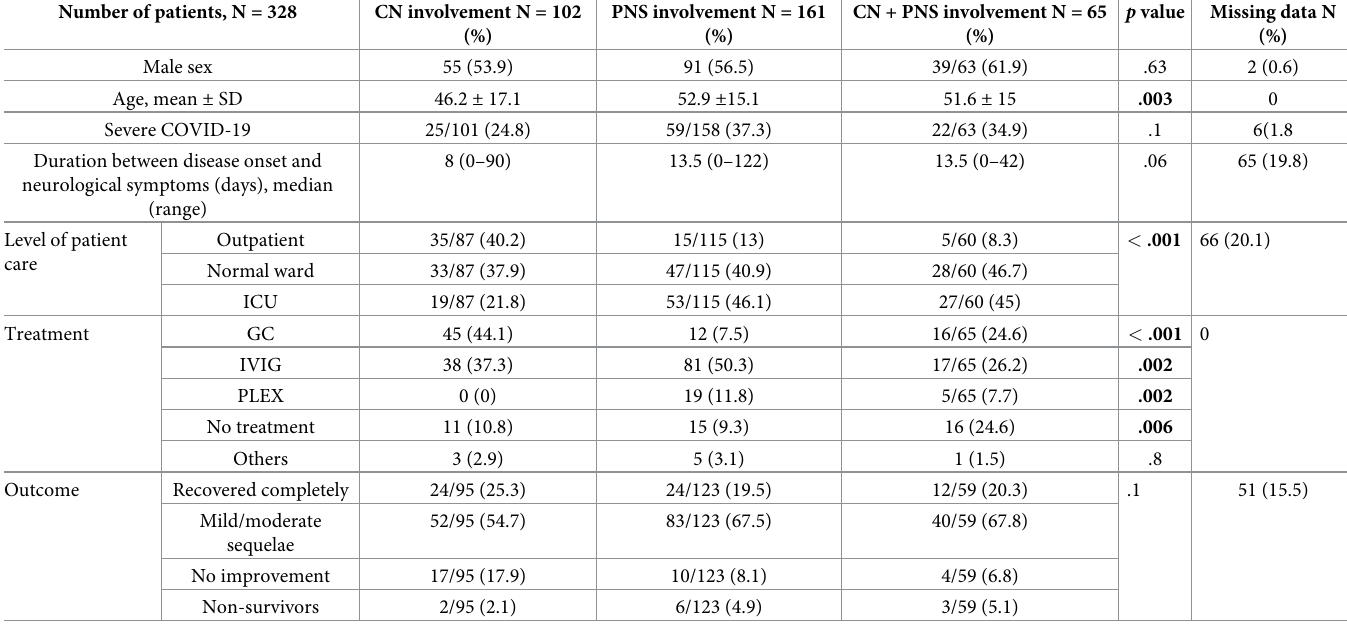
Table 4. Comparative clinical data according to different types of neurological involvement. Number of patients, N =